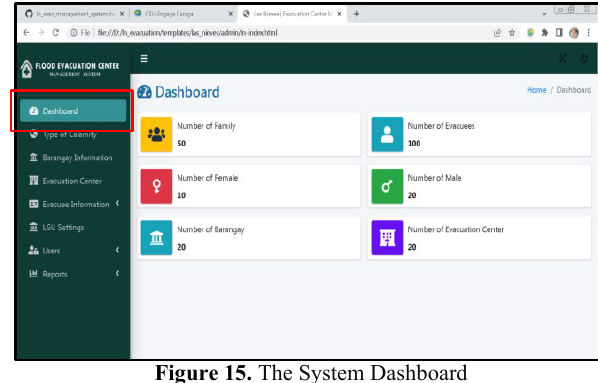
Figure 15. The System Dashboard